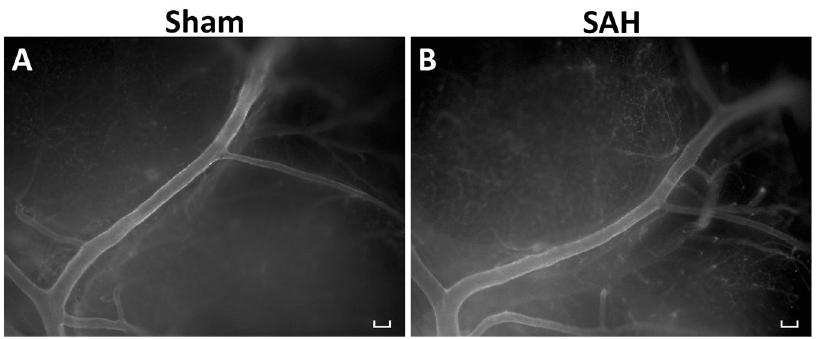
Figure 2. ROX SE staining of intracranial vasculature. Images of the left middle cerebral artery demonstrate cerebral vasospasm in mice that experienced subarachnoid hemorrhage ( B ) compared to sham-operated mice ( A ). Scale bar: 100 μ